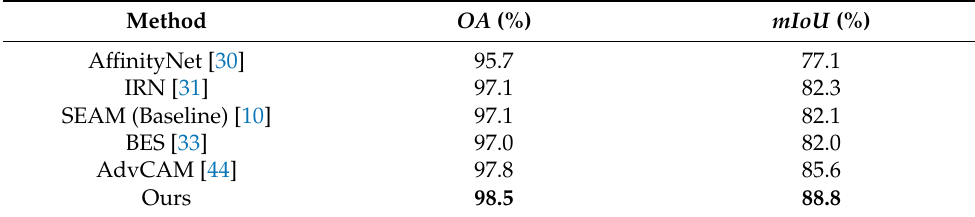
Table 6. Segmentation results on the Majiagou test set. The best score is in bold throughout all